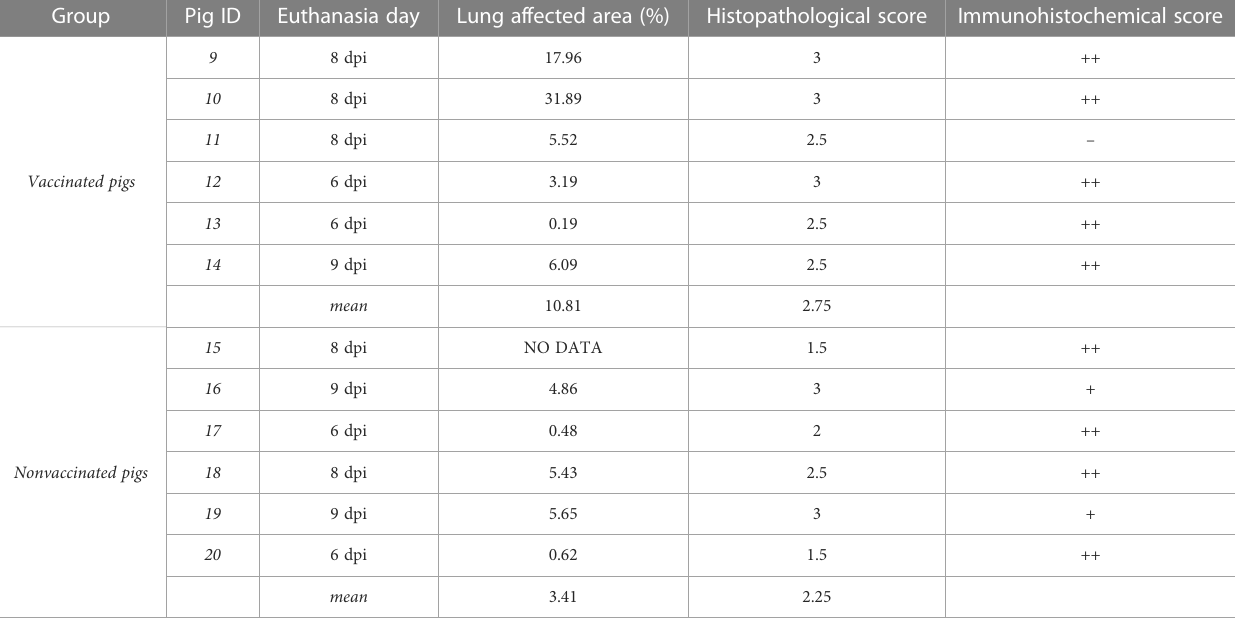
TABLE 2 Lung pathological results according to the percentage of total lung-affected area, and the semi-quantitative scoring for the degree of airways affectation and amount of immunoreactivity. Group Pig ID Euthanasia day Lung affected area (%)